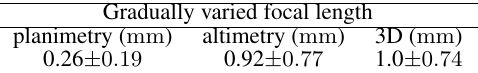
Table 4. Statistics of the residuals on